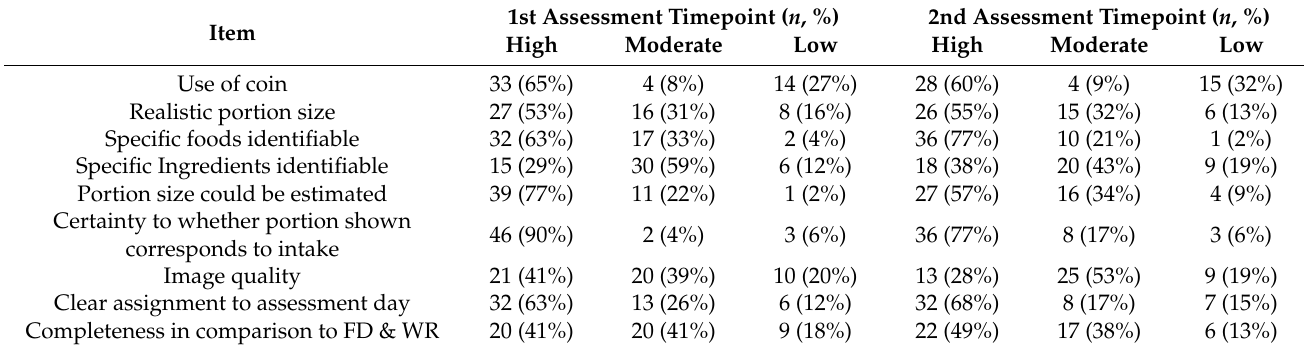
Table A2. Quality scoring for the PR method assessed by a research analyst. Item